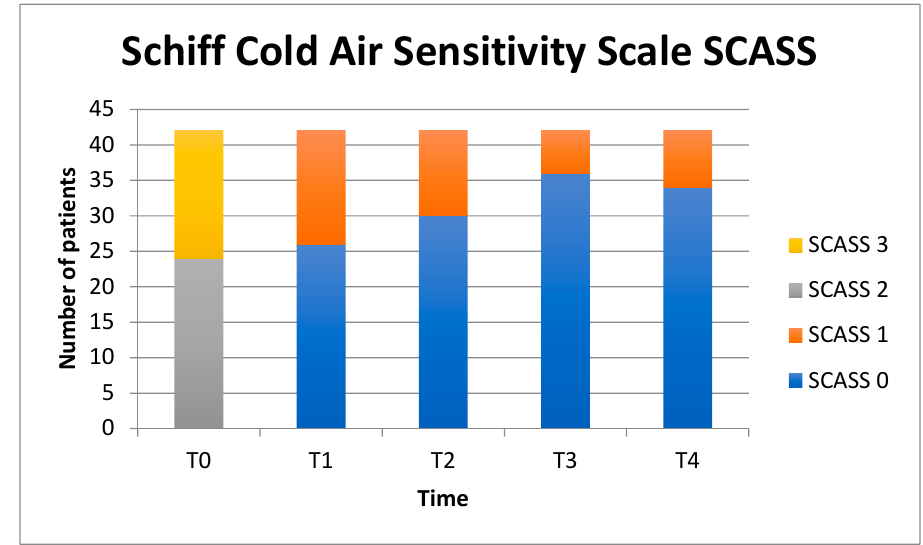
Figure 4. SCASS sensitivity test.